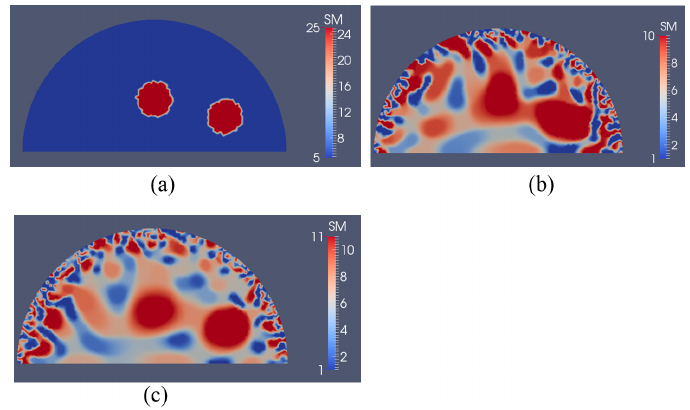
Figure 18. Shear modulus reconstructions with 5% noise. ( a ) Target shear modulus distribution for comparison; ( b , c ) reconstructed shear modulus distribution using 5 and 10 boundary displacement data sets, respectively (unit in the scale bar: kPa). Note: “SM” stands for shear modulus.